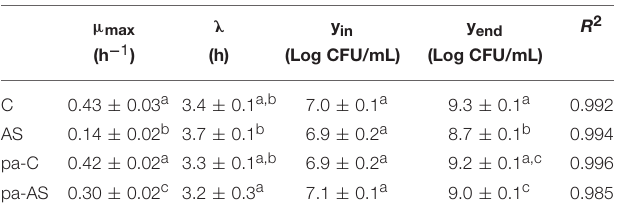
TABLE 1 | Growth kinetic parameters of L. innocua ATCC 33090 cultivated in conventional and acid stress conditions after non-pre-acid-adapted or